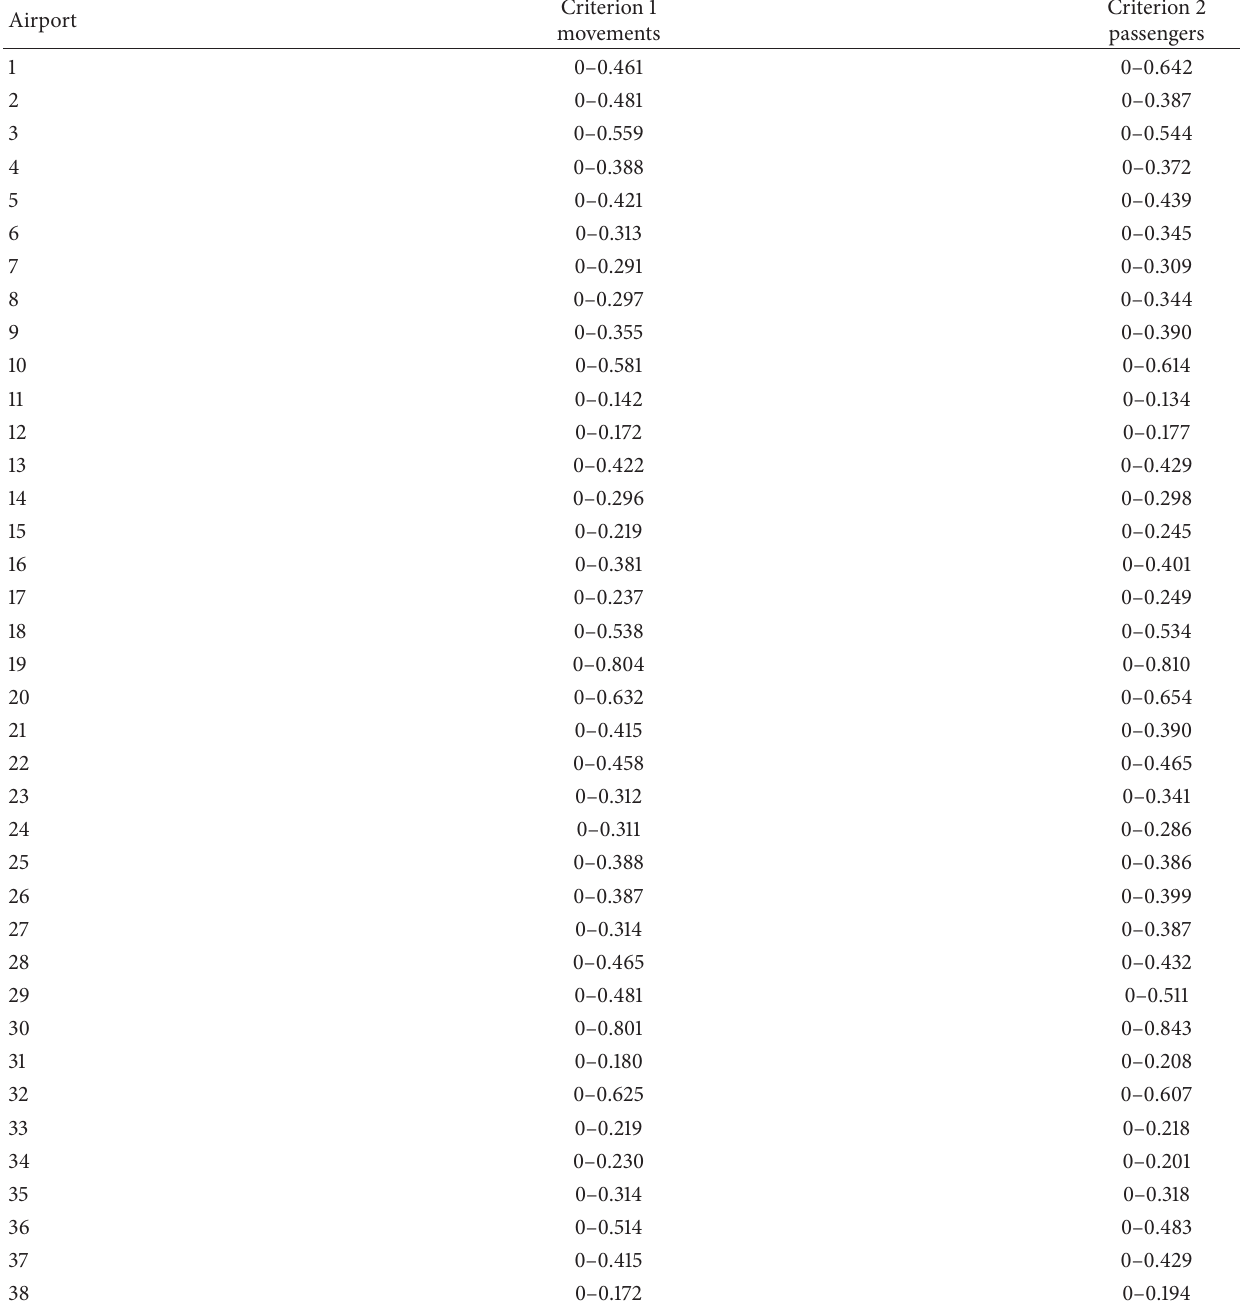
Table 2: Yearly ranges (15) for each airport coded as in Table